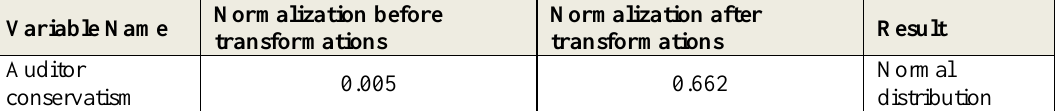
Table 4. The results of the Johnson transformation test for the dependent variable